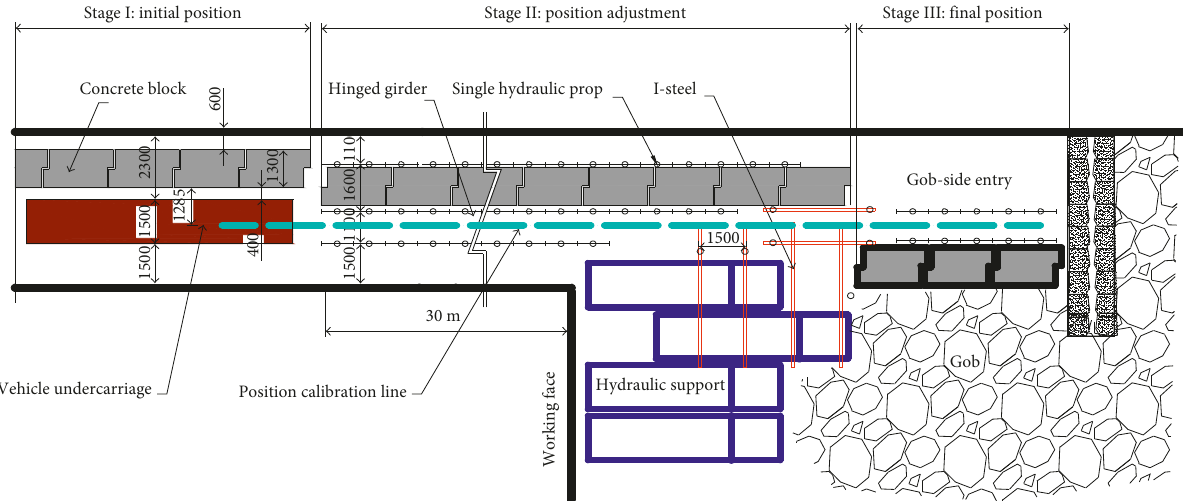
Figure 14: Construction procedure of the artificial wall for gob-side entry retaining.